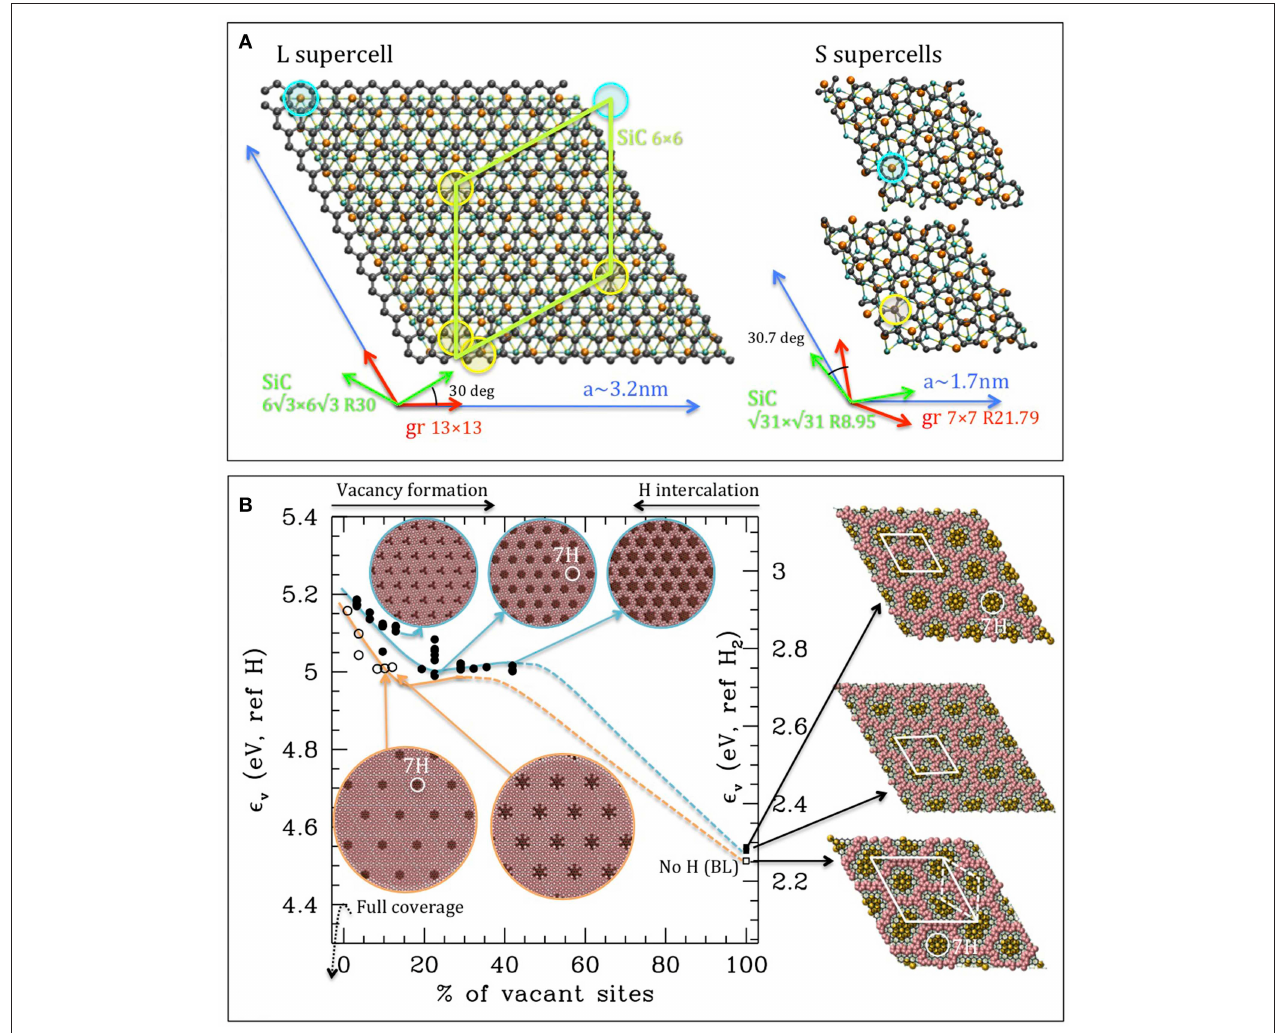
FIGURE 2 | (A) L and S supercells of the graphene on SiC systems. Two S cells with different relative translations of graphene with respect to SiC are reported. In all cases hollow type sites (with Si lying under the hexagon center) and top type sites (with Si under a carbon) are circled in cyan and yellow, respectively. Supercell lattice vectors, SiC and graphene lattice vectors are reported in blue, green and red, respectively (with sizes, and notations reported in the same color). The relative rotation of lattices is reported in black. In the L model, the 6 6 supercell of SiC is also reported, in green. Atom color coding: Black C in the carbon sheet; orange × = = location of H in the full coverage or of Si of the upper layer; cyan and yellow C and Si in the bulk. (B) Main plot: energy of the system per vacant Si site as a function = of the concentration of vacant sites referred to the system with full coverage. The scale on the left consider the extraction of H in atomic form, that on the right the extraction in molecular form (the two differ by a rigid shift corresponding to half of the H 2 formation energy. The completely hydrogenated system—QFMLG—is out of scale below the x axis). The filled dots correspond to vacancies located in sites with the √ 31 6 6), empty dots to vacancies located in √ 31 R8.95 periodicity ( × ∼ × 6 √ 3 6 √ 3 R30 (nearly 1/3 dense). Analogously, filled and empty squares correspond to the buffer layer (no H) with the two periodicities (The blue and orange lines × are eye-guides for the two sets of points). The circular insets report representation of the system with vacancies of different size in the two symmetries as indicated by the arrows. The completely dehydrogenated systems (BL) are reported on the right, with the following color code: the C atoms of the “crest” are represented in pink as large spheres, while the Si sites more strongly bound to the buffer layer are in orange. The hexagonal lattice is superimposed in black. 7H type vacancies are circled in white. Data are taken with permission from Cavallucci and Tozzini (2016), Cavallucci et al. (2018), Murata et al. (2018) and recast in different